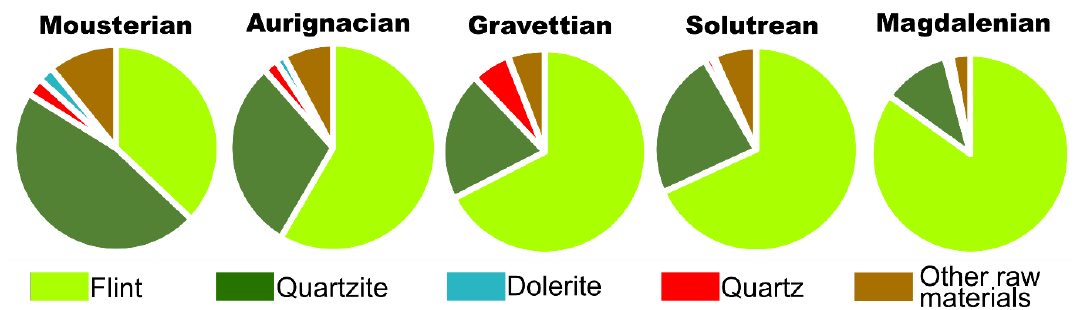
Figure 5. Pie charts representing percentages of raw material grouped by techno-complexes.